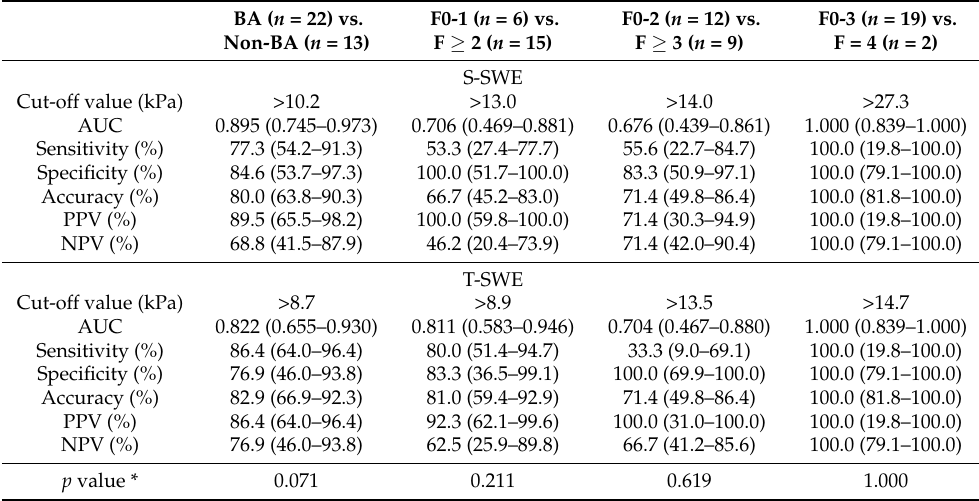
Table 2. Diagnostic performances of S-SWE and T-SWE in identifying biliary atresia among 35 patients and predicting liver fibrosis among 21 patients.